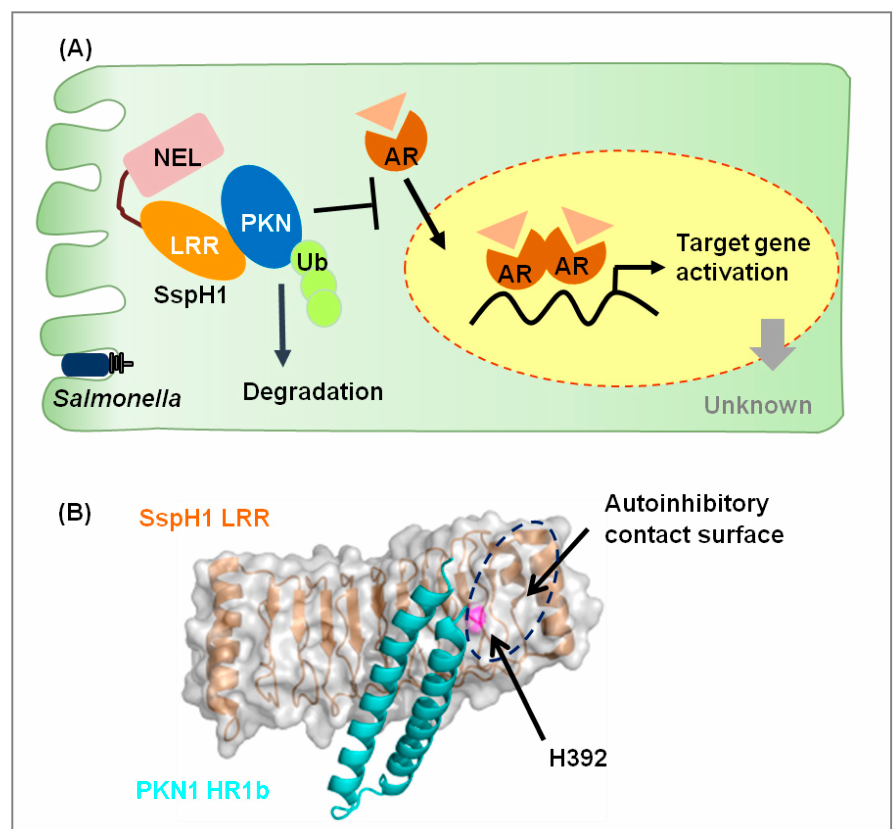
Figure 2. Novel E3 ligase (NEL) family ubiquitin ligases. ( A ) SspH1 is secreted into host cells by Salmonella T3SS SPI-1 and SPI-2. The leucine-rich repeat (LRR) domain of SspH1 recognizes and interacts with the homology region 1b (HR1b) coiled-coil subdomain of protein kinase N1 (PKN1). PKN1 is ubiquitinated and degraded by SspH1, resulting in down-regulation of androgen receptor (AR) signaling. In the cytoplasm, AR (in complex with heat shock proteins 70 and 90) interacts with ligands such as testosterone, and then translocates to the nucleus to act as a transcription factor; ( B ) SspH1-PKN1 interaction surface. The figure illustrates the crystal structure of the LRR of SspH1 in complex with the HR1b of PKN1 (cyan) (PDB ID 4NKG). Protein surface and cartoon representation of SspH1 are shown in gray and orange, respectively. H392 of SspH1 is shown in magenta. The contact interface between LRR and NEL is indicated by a dashed oval. The molecular graphics were prepared using PyMOL